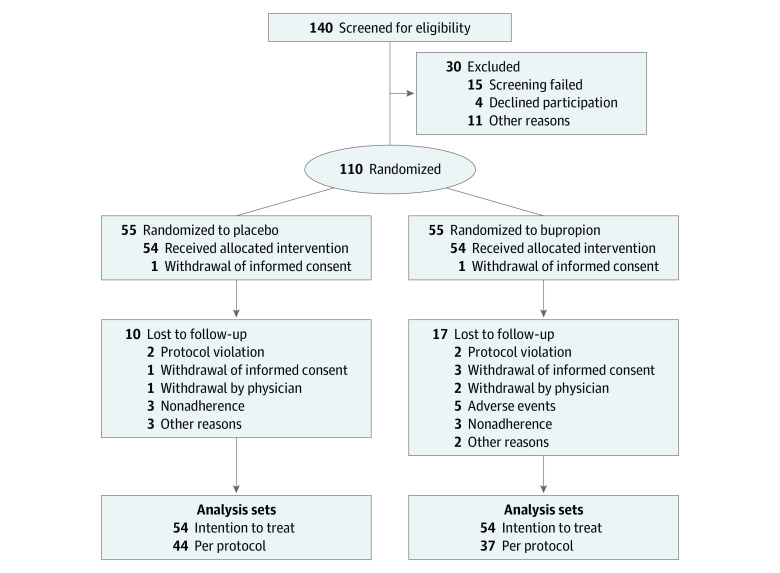
Flow Diagram of Patient Progress Through the Trial of Bupropion vs Placebo for the Treatment of Apathy in Alzheimer Disease